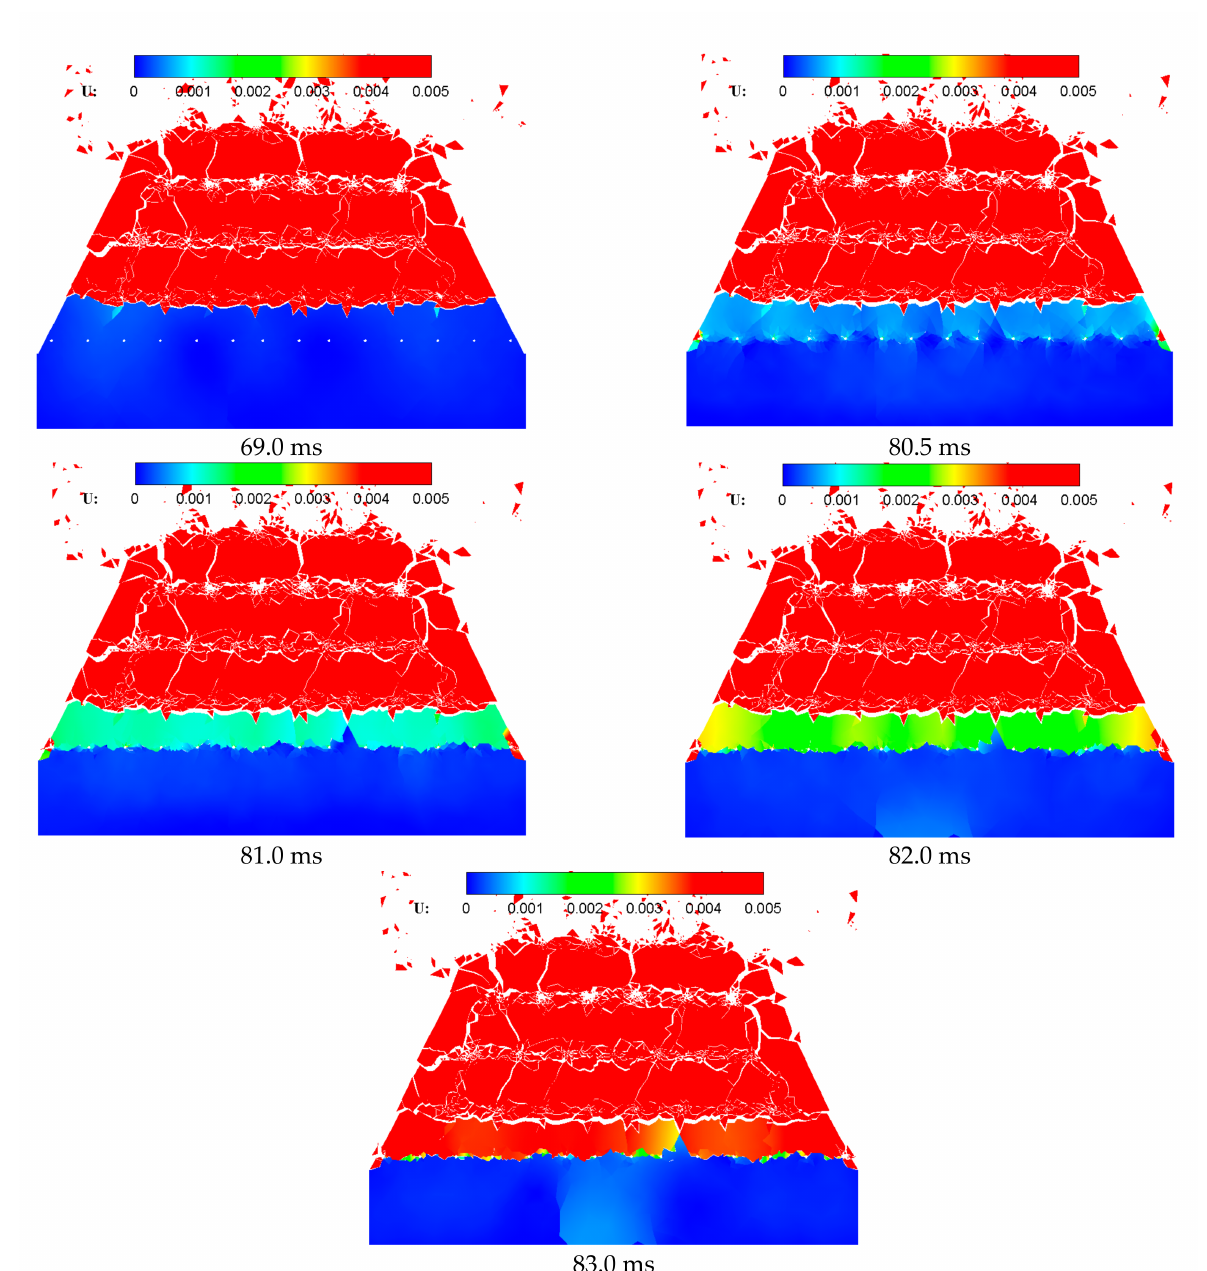
Figure 15. Displacement distribution and rock fracture and fragmentation process using the double side drift